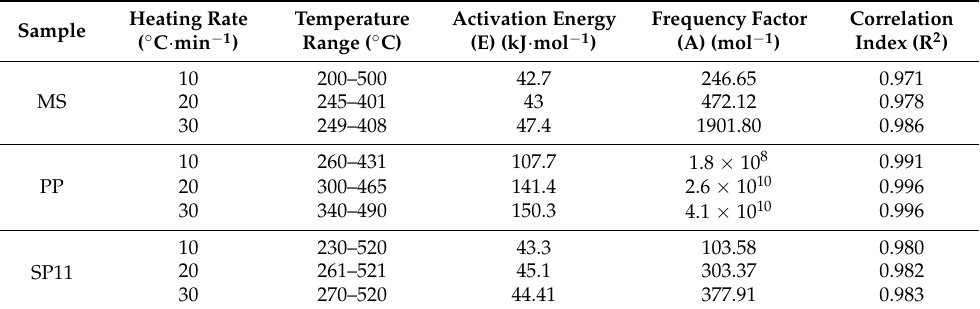
Table 2. Pyrolysis kinetic parameters of MS, PP, and SP11 at different heating rates.